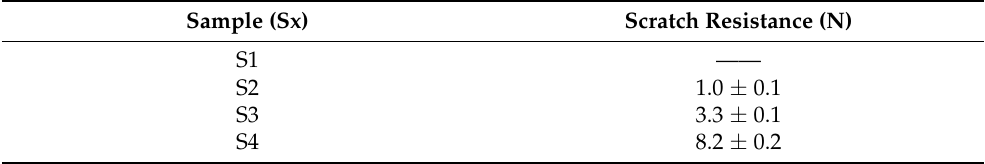
Table 4. Scatch critical loads of S2, S3, and S4 samples.